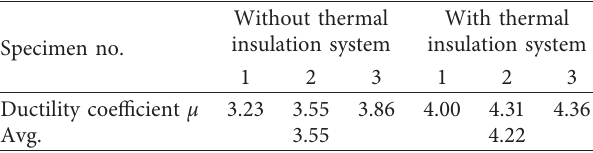
Table 3: The ductility coefficient of the sample. Specimen